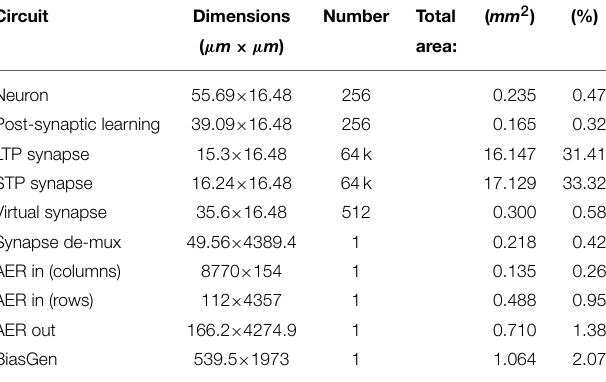
TABLE 1 | Circuits area